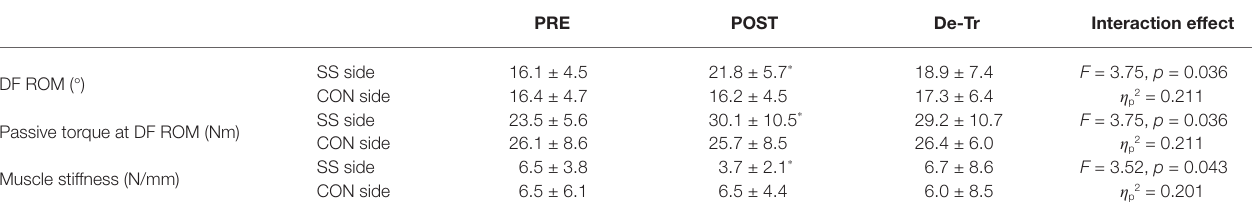
TABLE 1 | The effect of the static stretching (SS) program on DF ROM, passive torque at DF ROM, and muscle stiffness of medial gastrocnemius (MG) during passive dorsiflexion test.